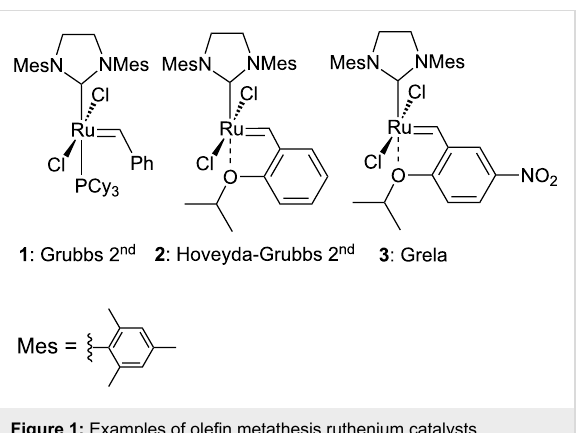
Figure 1: Examples of olefin metathesis ruthenium catalysts.